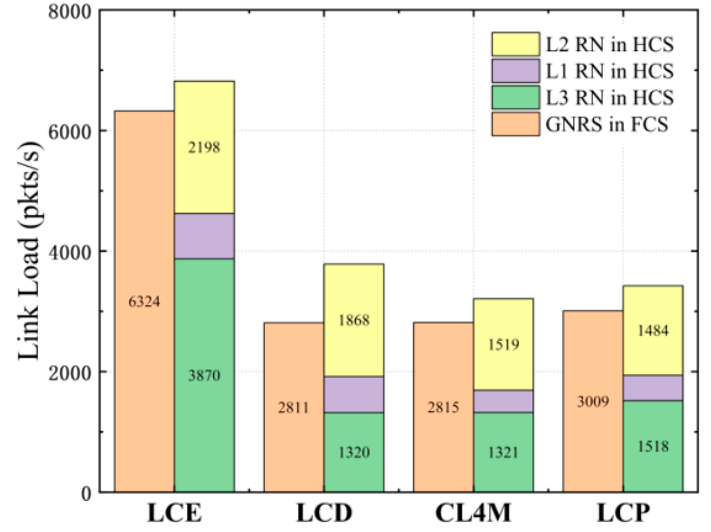
Figure 10. Average access load of each level’s resolution node.